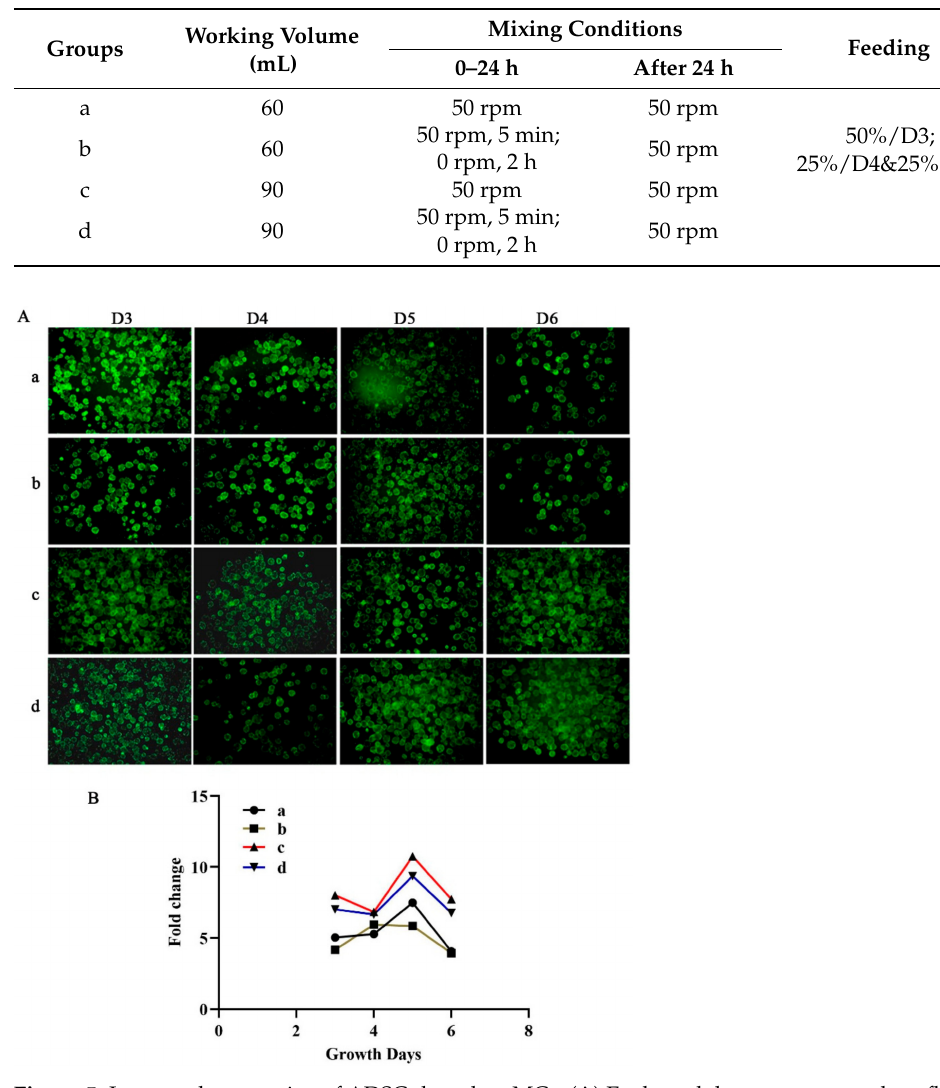
Table 1. Optimization of the culture conditions of ADSCs on MCs.